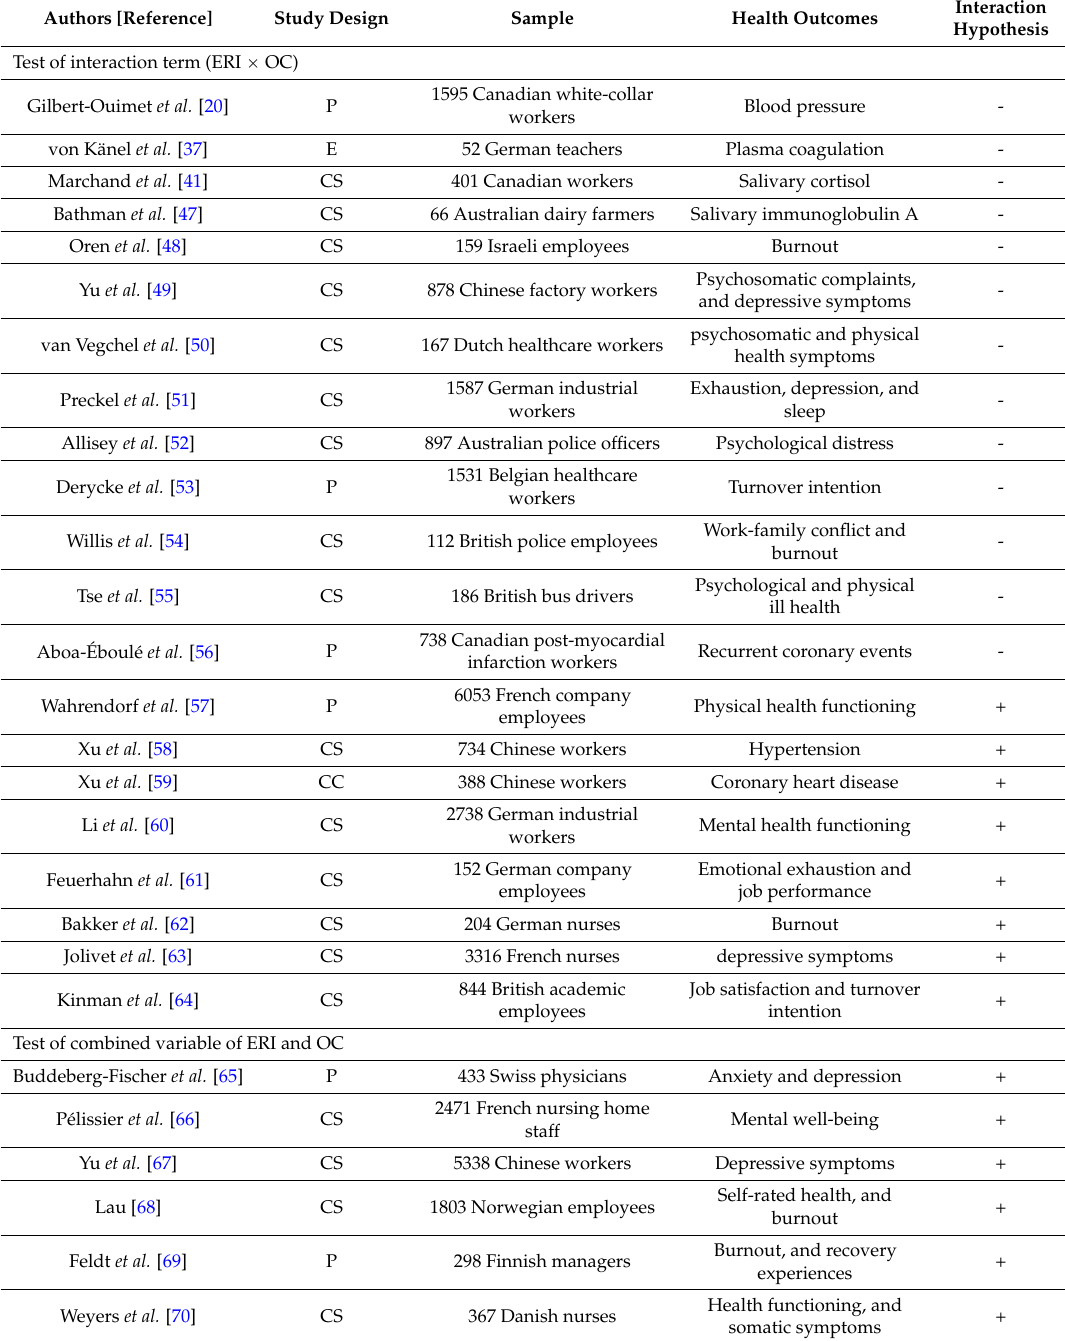
Table 2. Summary of moderating effects of over-commitment on associations between effort-reward imbalance and